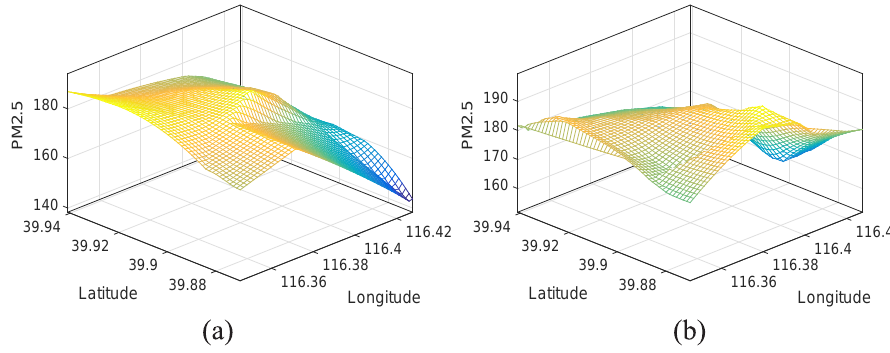
Figure 16. Recovered signals (sensing images). ( a ) The generated sensing image based on interpolation method; ( b ) The generated sensing image based on enhanced crowdsensing